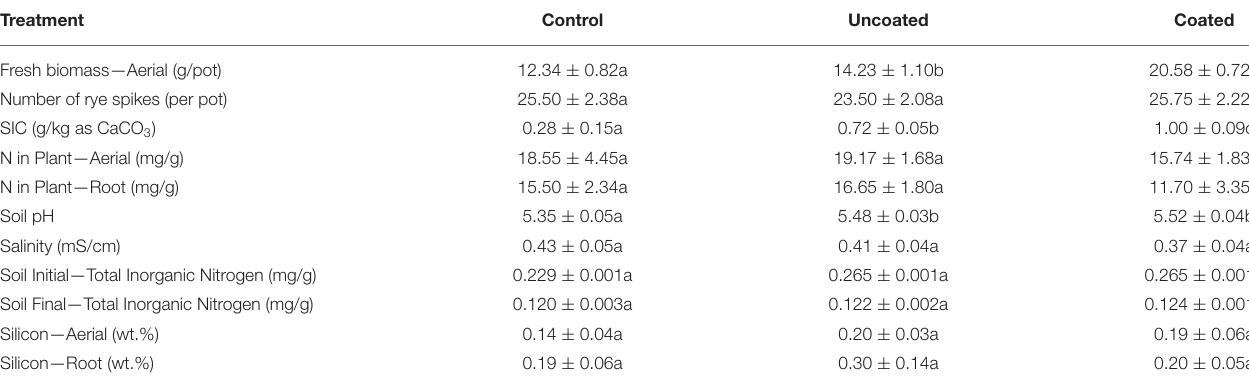
TABLE 2 | Effect on three treatments of spring rye: control, uncoated, and coated. Treatment